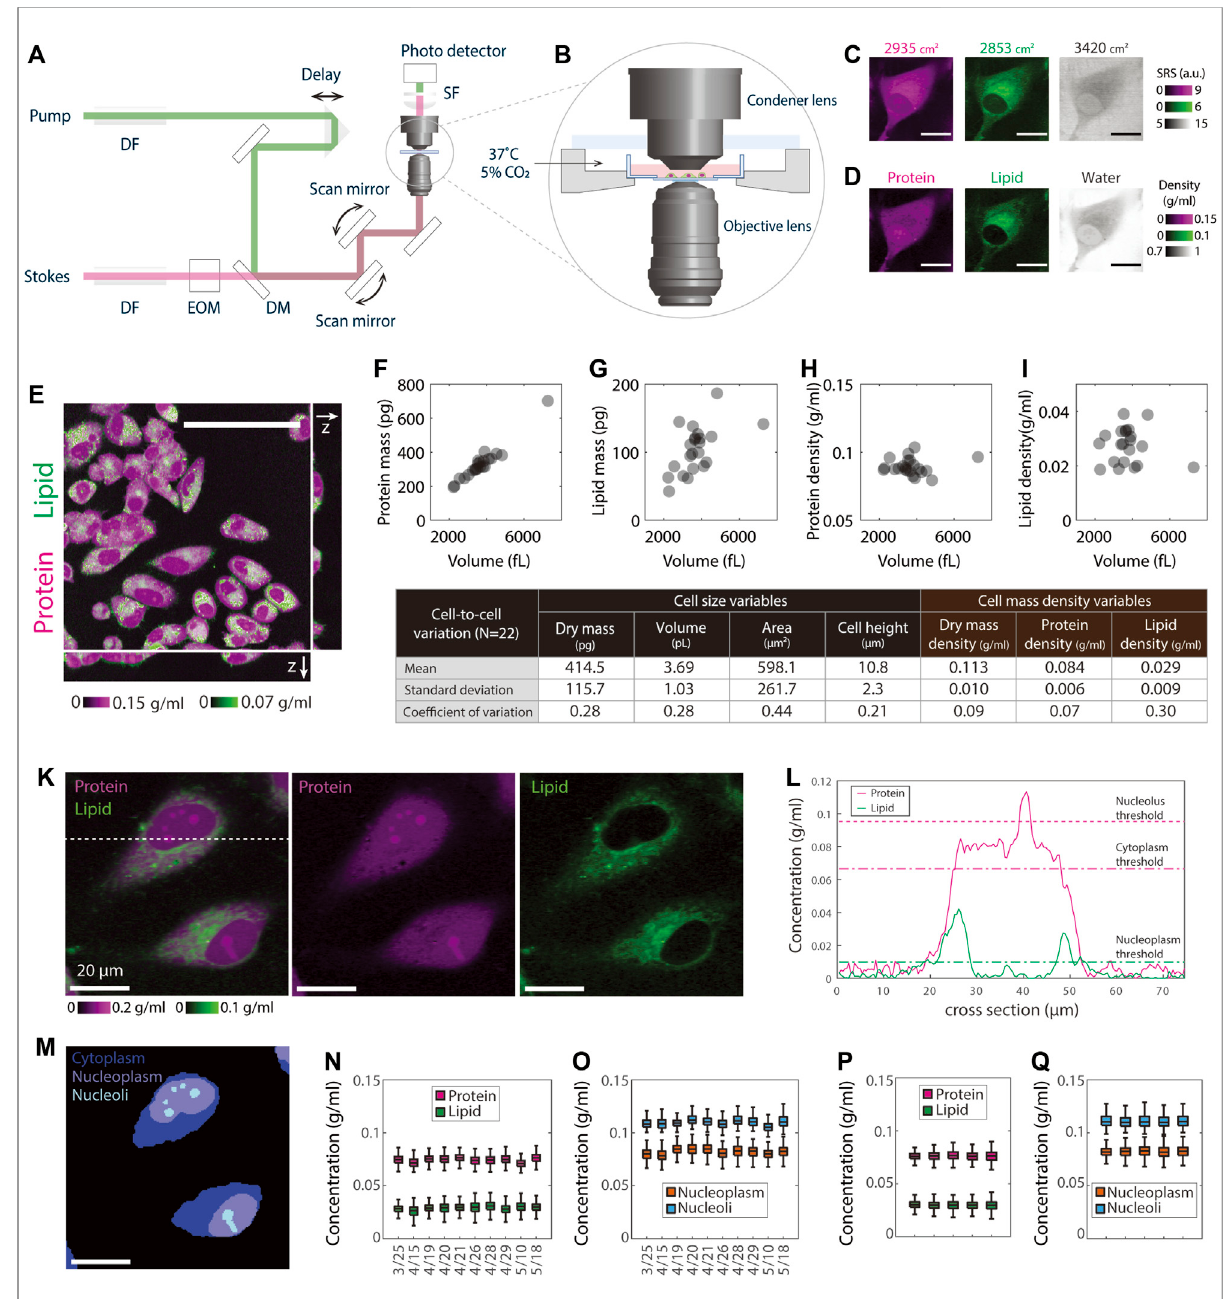
FIGURE 1 NoRI measurement of single cell mass density demonstrating the stability of protein and lipid mass densities. (A) Schematic of the stimulated Raman scattering microscope. DF, dense fl int; EOM electro-optical modulator; DM, dichroic mirror; SF, short-pass fi lter. (B) A close-up view of the environmental chamber for live cell NoRI imaging. (C) Raw SRS images acquired using the SRS microscope at the Raman bands of 2853, 2935, and 3420 cm − 1 ,correspondingtothevibrationalmodesofCH 2 ,CH 3 ,andwater,respectively.Scalebar,20 µm.Imageintensitiesarederiveddirectly from the photocurrent at the photodetector. (D) The local concentrations of protein, lipid, and water are computed from the raw SRS images by the NoRIalgorithmfollowingOhetal.,2022. (E) z-stackNoRIimageof fi xedA7cellsdisplayingproteinandlipidconcentrations.Scalebar,100 µm. (F – I) Correlation plots ofproteinmass (F) ,lipidmass (G) ,proteindensity (H) ,andlipiddensity (I) withcell volumemeasuredfromsingle cells( n =22)in (E) . The correlation coef fi cient R is 0.97 (p < 1e-13) for protein mass, 0.56 ( p = 0.007) for lipid mass, 0.06 ( p = 0.78) for protein density, and − 0.18, ( p = 0.42) for lipid density, respectively. (J) Table summarizing the mean, standard deviation, and CV of the cell size and cell density variables in (F – I) . (K) Representative NoRI images of live HeLa cells with protein density displayed in magenta and lipid density displayed in green. Scale bar, 20 µm. (L) Proteinandlipiddensitypro fi lesalongthedashedcrosslinein (K) .Thedashedlinesindicatetheprotein(magenta)andlipid(green)thresholdsusedin the segmentation. (M) Segmentation of (K) indicating cell bodies, nuclei, and nucleoli. Cytoplasm represents the area inside the cell body outside of the nucleus. Nucleoplasm refers to the area inside the nucleus excluding the nucleoli. (N – O) Day-to-day variability of HeLa cell mass density